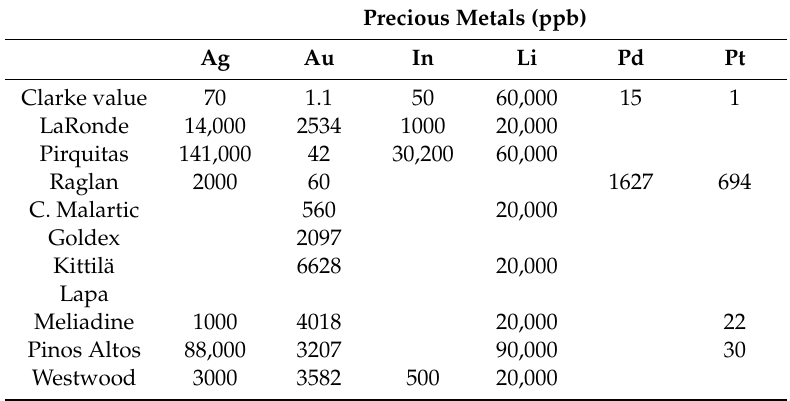
Table A2. Precious elements in the ores’ samples. The values above ten times the Clarke value are in